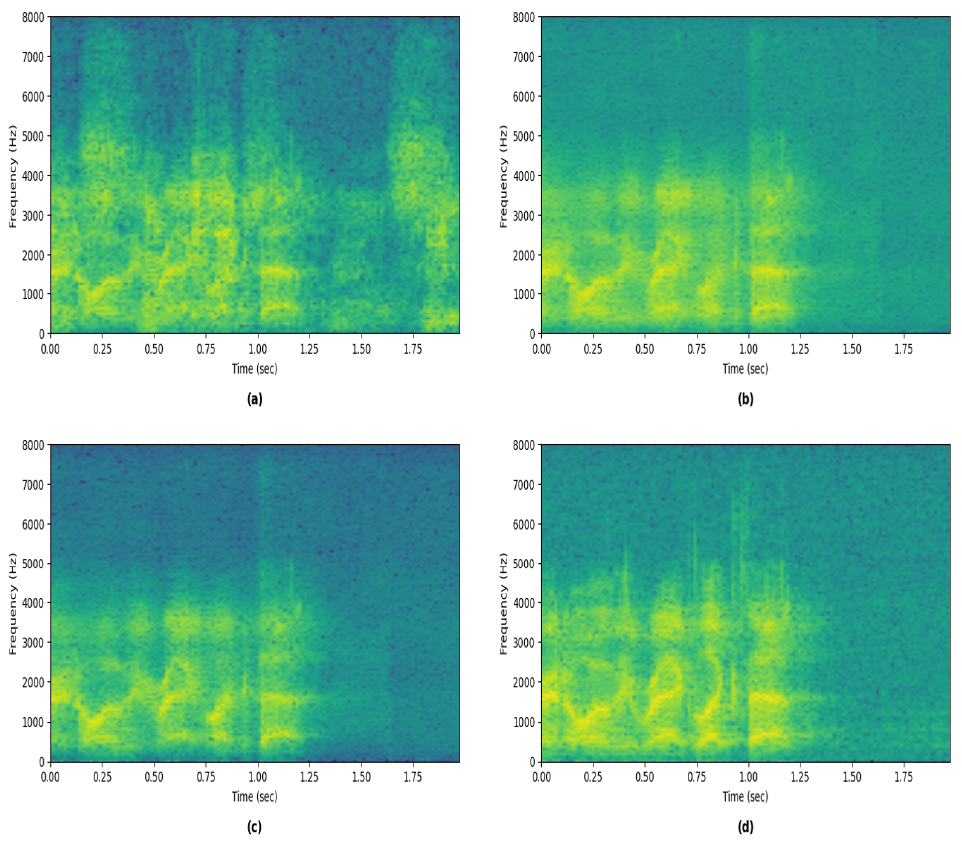
Figure 4. Visualization of spectrograms of the different stages’ outputs. ( a ) Error signal spectrogram. ( b ) Spectrogram of the signal reconstructed from the masking stage’s output. ( c ) Spectrogram of the refinement stage’s output. ( d ) Near-end signal’s